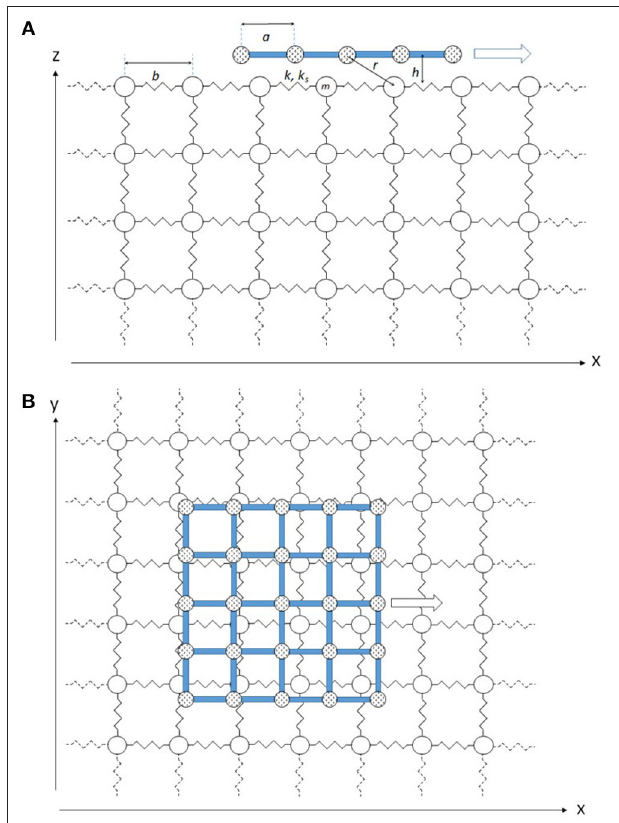
FIGURE 1 | Schematic of model system: (A) cross section of typical rigid slider and elastic slab; (B) top view of system.